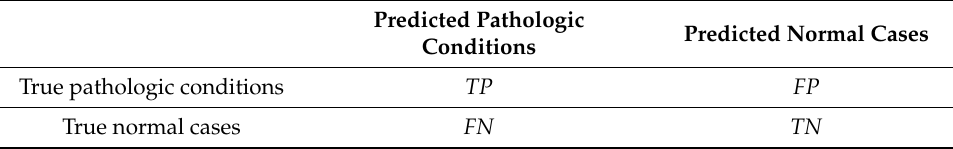
Table 1. Confusion matrix for a MRNet-based classification